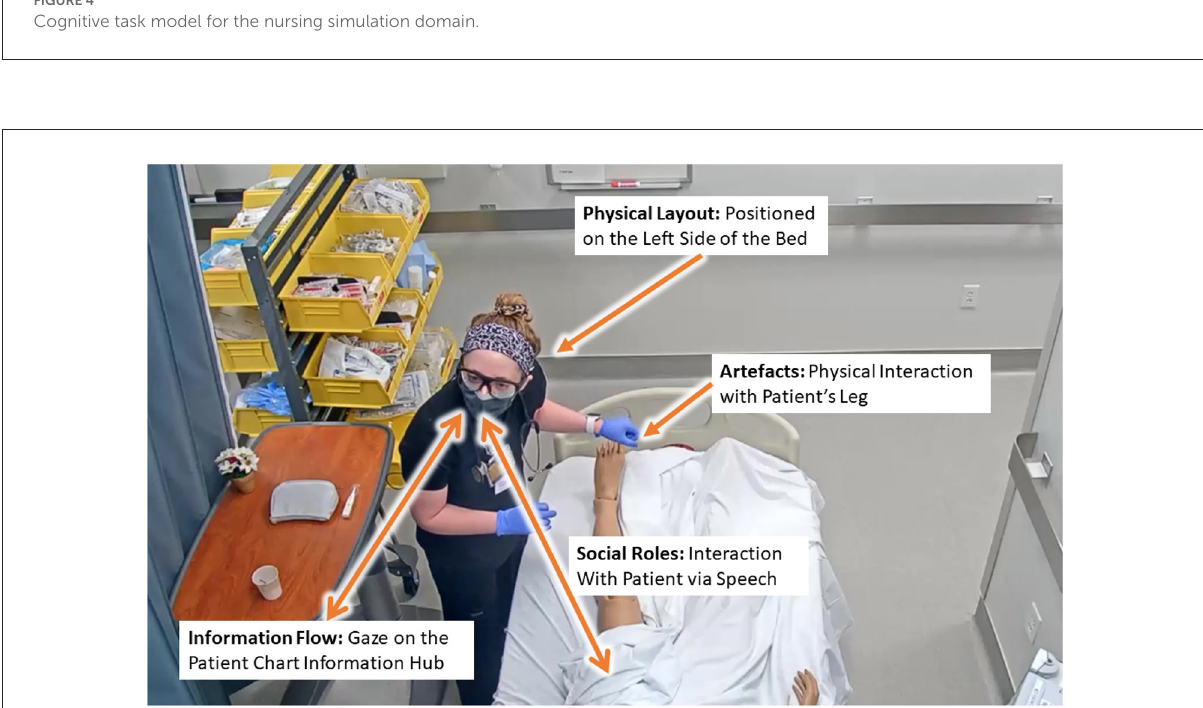
FIGURE5 Example of the distributed cognition in the context of nurse training across the physical layout, artifacts, and social